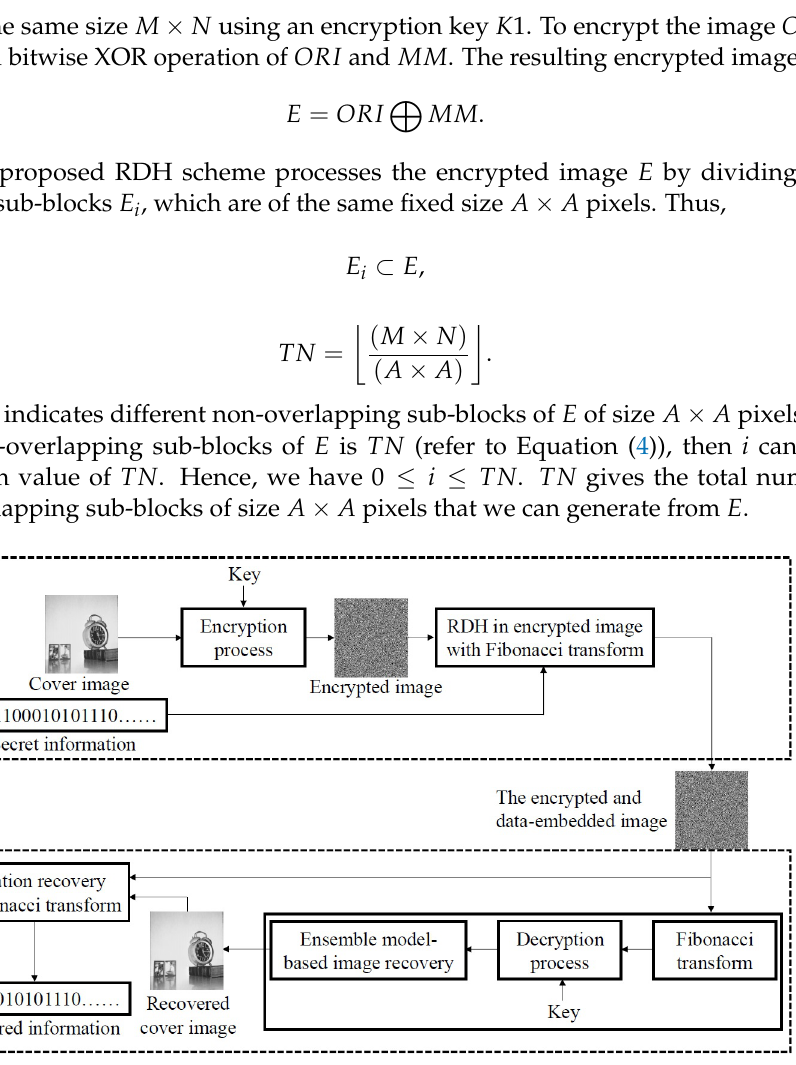
Figure 1. Schematic diagram of the